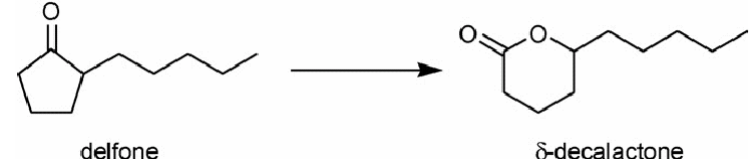
Figure 5. Baeyer-Villiger oxidation of delfone into δ -decalactone over Sn-BEA